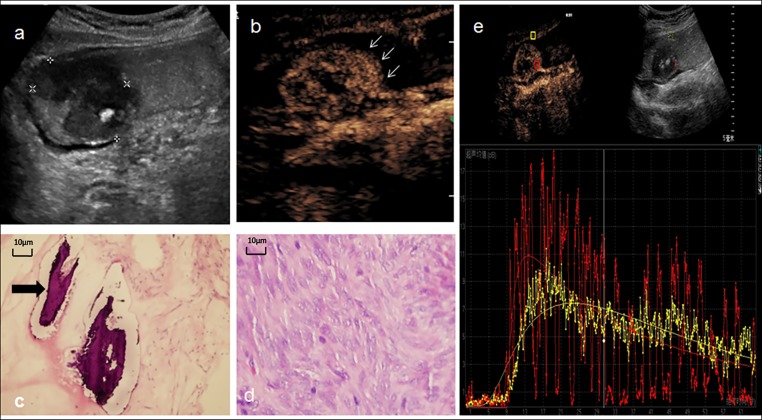
A 43-year-old woman with a gastrointestinal stromal tumor.a: Conventional trans-abdominal ultrasound with oral contrast agent showed a lobulated heterogeneous hypoechoic lesion (calipers) located in antrum of stomach, a hyper-echoic calcification plaque could be detected inside of the tumor. b: DCUS showed a ring-like hyper-enhancement (arrow) and heterogeneous hyper-enhanced inside of the lesion. c,d: Microscopic certificated the calcification in GIST (arrow in c)and fascicular proliferation of spindle-shaped cells.(d)(hematoxylin and eosin, × 200). e: Time-intensity curve depicted the lesion (red line) have higher PI and faster AT, TTP than surrounding tissue (yellow), final pathology result classified this GIST into high-risk category.